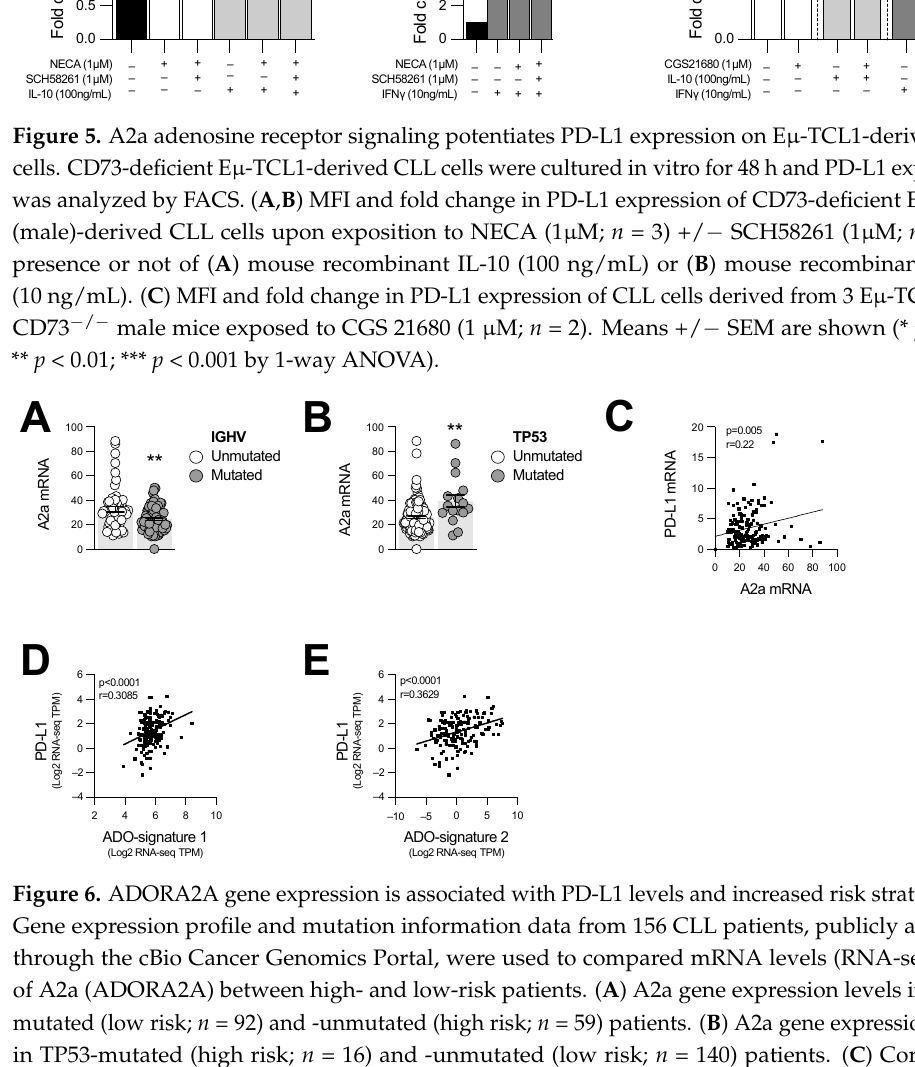
Figure 5. A2a adenosine receptor signaling potentiates PD-L1 expression on Eµ-TCL1-derived CLL cells. CD73-deficient Eµ-TCL1-derived CLL cells were cultured in vitro for 48 h and PD-L1 expres- sion was analyzed by FACS. ( A , B ) MFI and fold change in PD-L1 expression of CD73-deficient Eµ- TCL1 (male)-derived CLL cells upon exposition to NECA (1µM; n = 3) +/ − SCH58261 (1µM; n = 2) in presence or not of ( A ) mouse recombinant IL-10 (100 ng/mL) or ( B ) mouse recombinant IFN- γ (10 ng/mL). ( C ) MFI and fold change in PD-L1 expression of CLL cells derived from 3 Eµ-TCL1 tg/wt CD73 − / − male mice exposed to CGS 21680 (1 µM; n = 2). Means +/ − SEM are shown (* p < 0.05; ** p < 0.01; *** p < 0.001 by 1-way ANOVA).